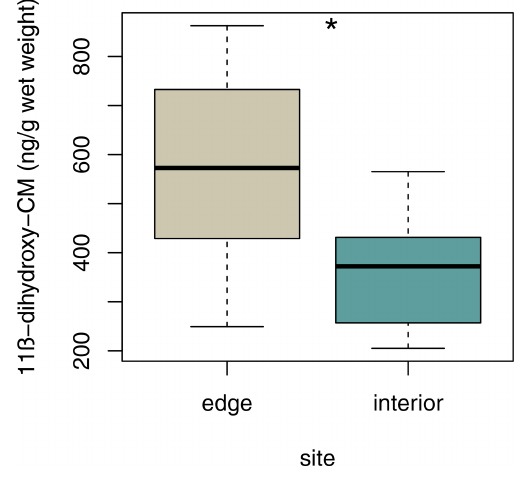
Figure 6. Median faecal glucocorticoid metabolite concentrations for each study site. Depicted are medians (black horizontal lines) and interquartile ranges (boxes).